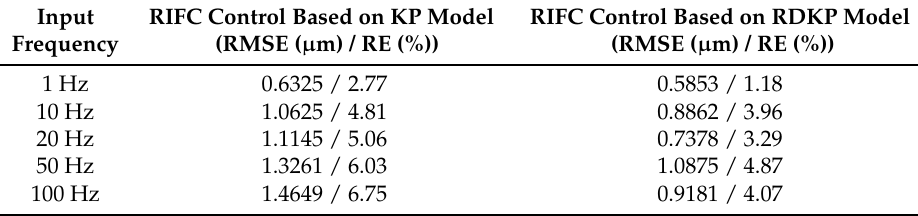
Table 3. Comparison of tracking errors between the classic KP model and the proposed RDKP model under triangular trajectories with diverse input frequency based on the RIFC control